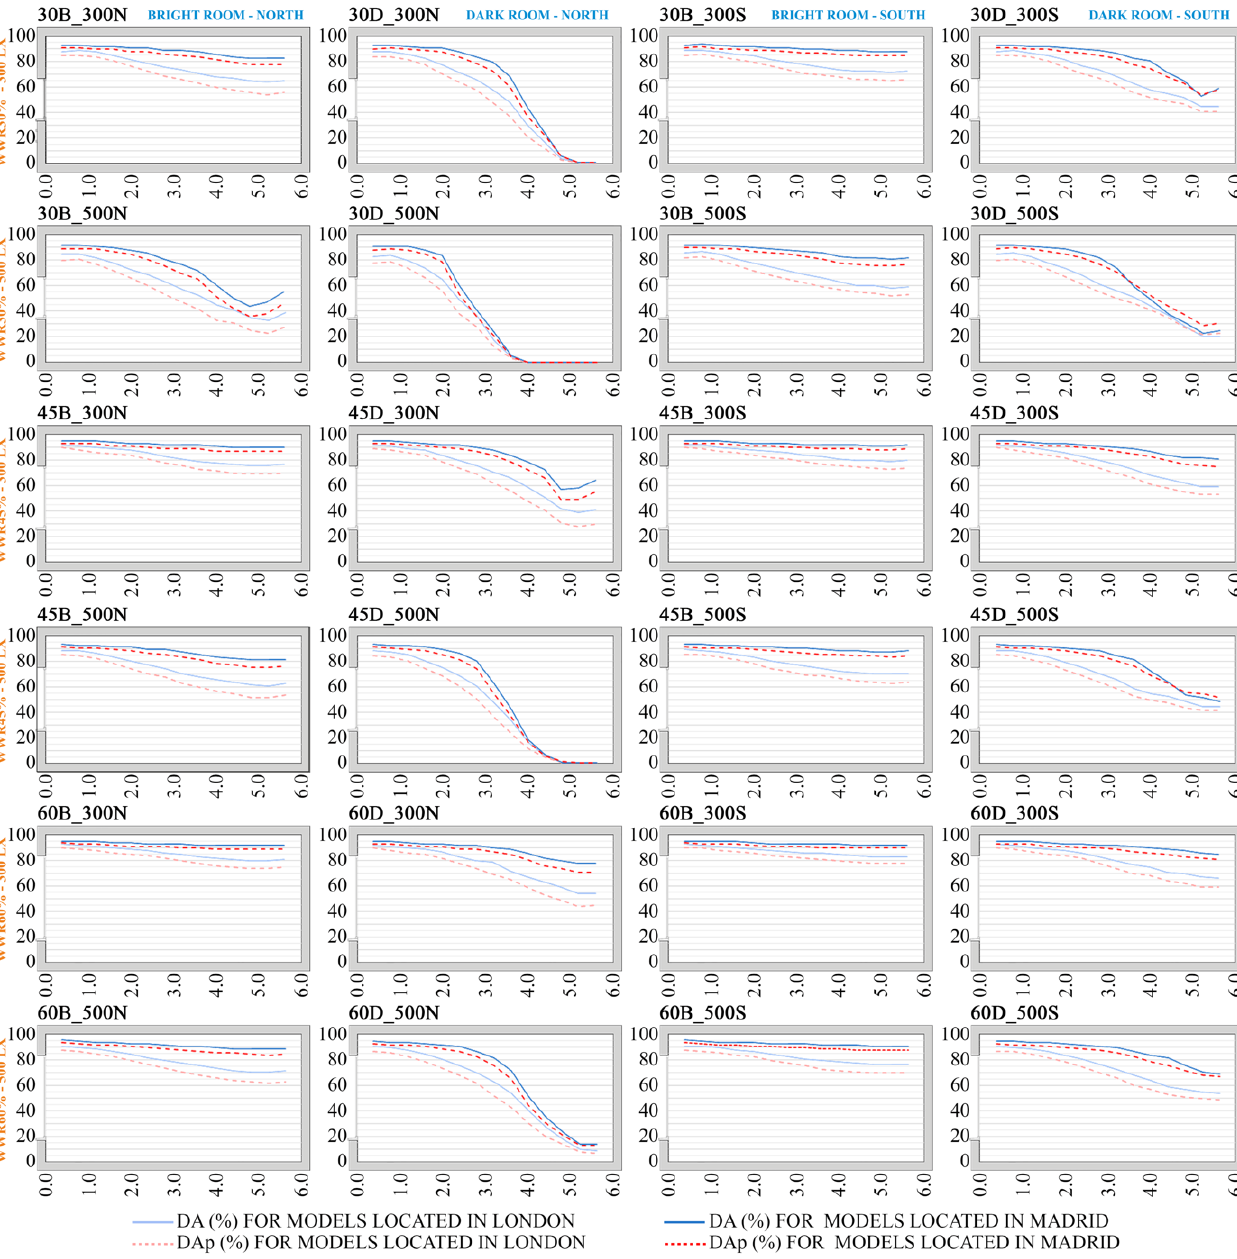
Figure 7. Quantification of DA and DAp in the calculation models according to room